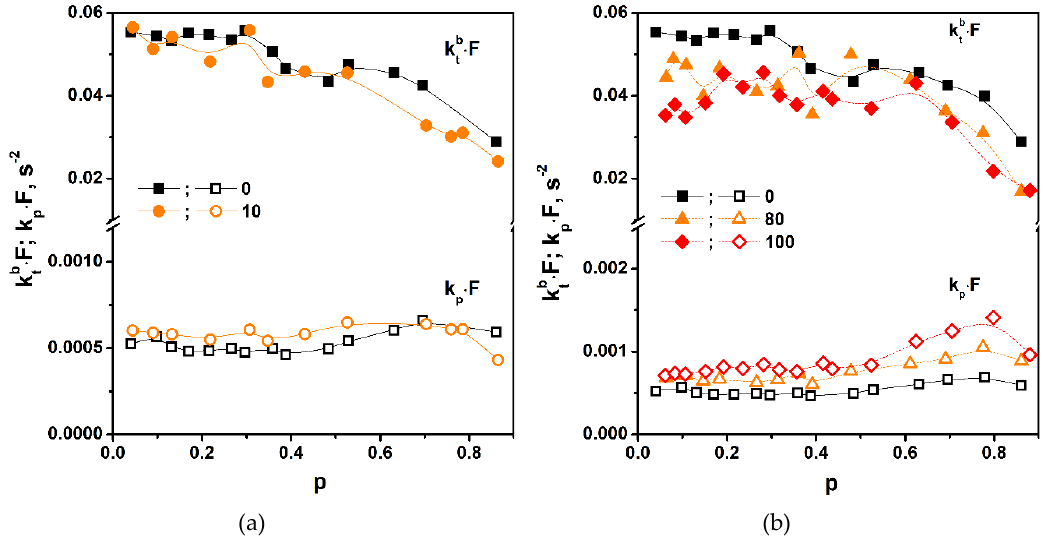
Figure 10. Parameters related to propagation ( k p · F ) and termination ( k tb · F ) rate coefficients as a function of the double bond conversion ( a ) LM/1M-POSS system and ( b ) the LM/TSM system. The numbers indicate the modifier content (mol %) in the mixture. Polymerization temperature: 40 °C. The lines are eye guides.